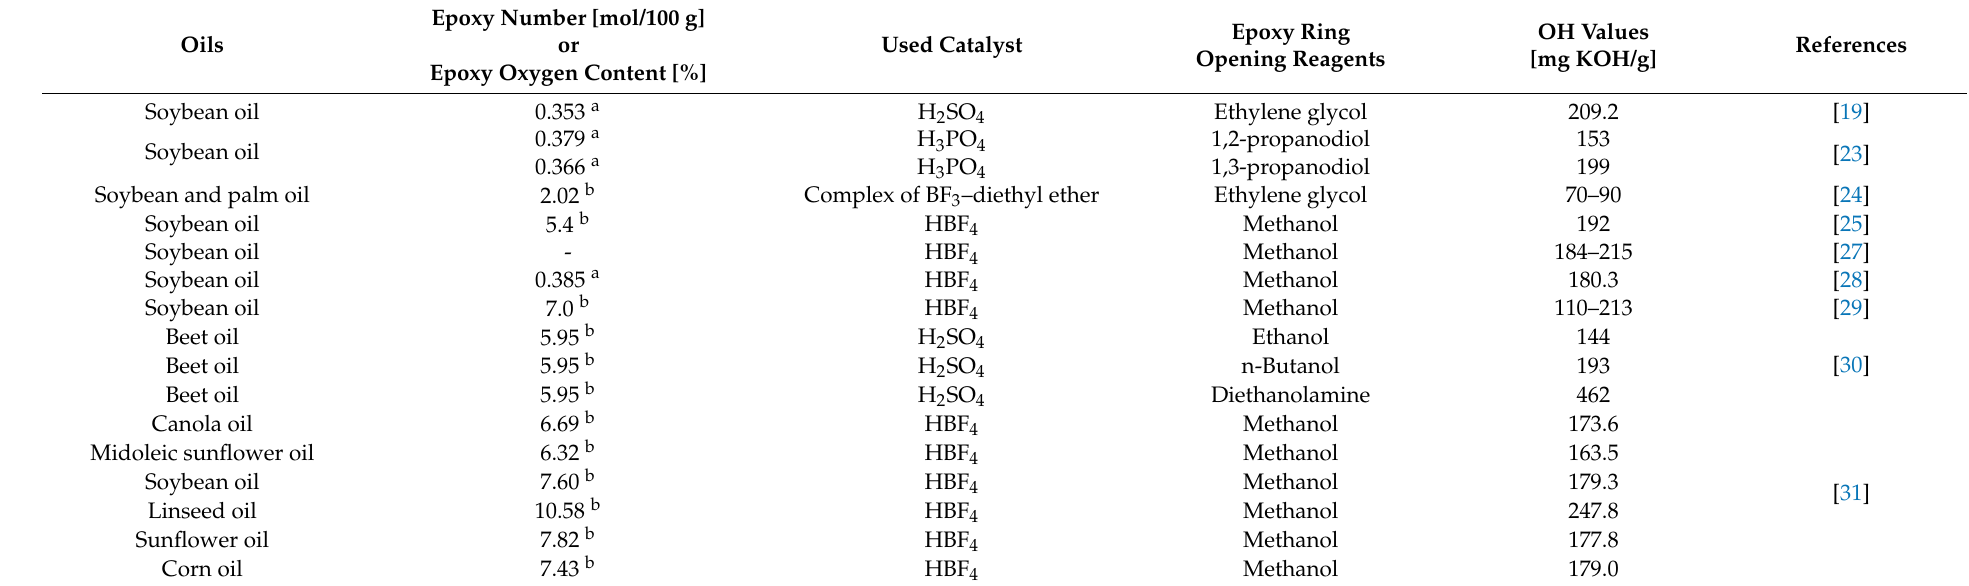
Table 1. Properties of epoxidized vegetable oils and oil-based